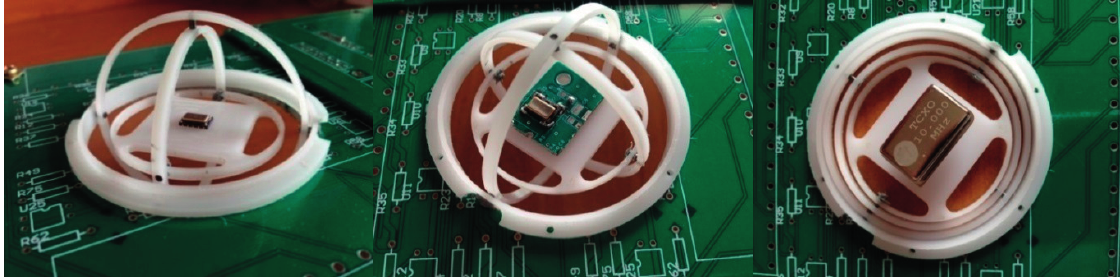
Figure 5. GPS receiver crystal oscillators on the engineering model of the gyroscopic mounting.